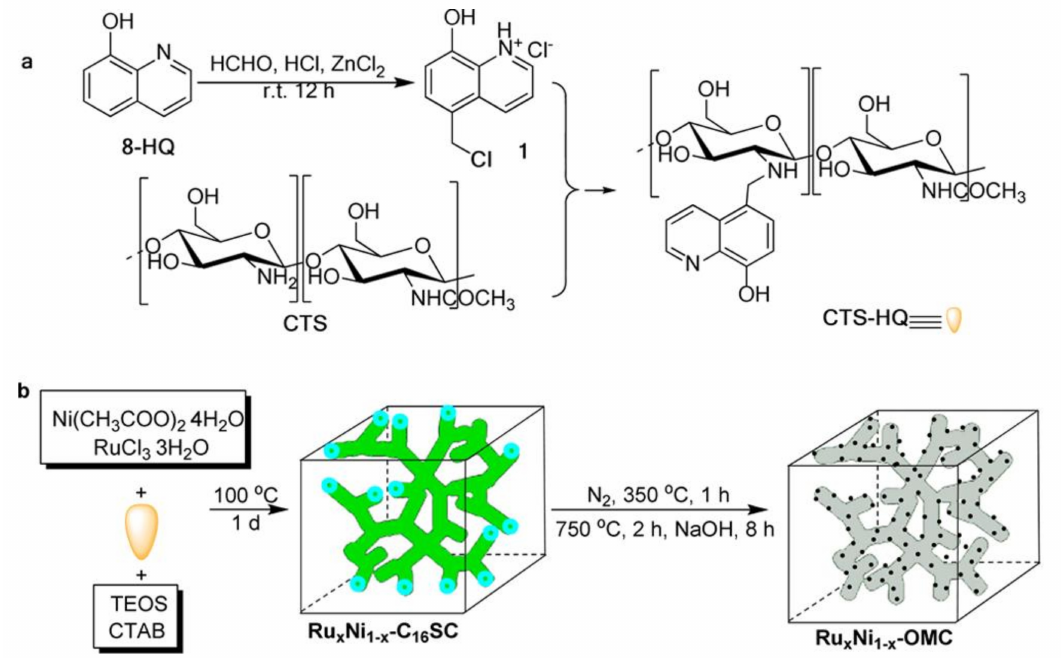
Figure 5. Synthesis of Ru x Ni x − 1 -ordered mesoporous carbon (OMC) catalysts, ( a ) Modification of chitosan with 5- chloromethyl-8-quinolinol; ( b ) Synthetic route for the preparation of OMC-supported bimetallic catalyst from precursor composite (Ru x Ni 1 − x -C 16 SC) and modified chitosan. Reproduced from ref [64] with permission from American Chemi- cal